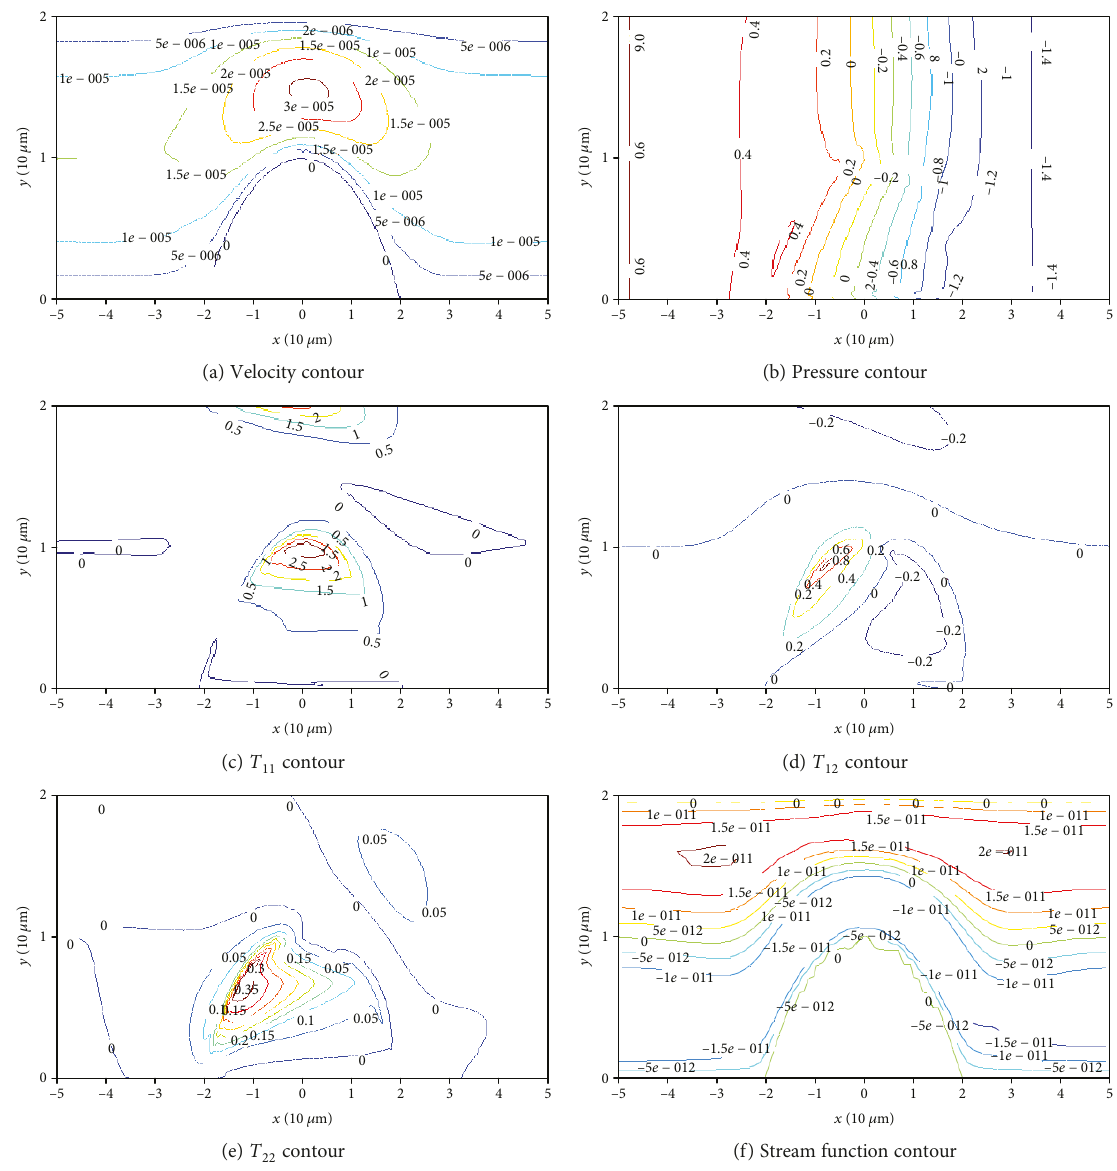
Figure 2: The fl ow fi eld